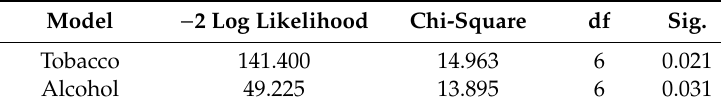
Table 3. Tobacco and alcohol model fitting